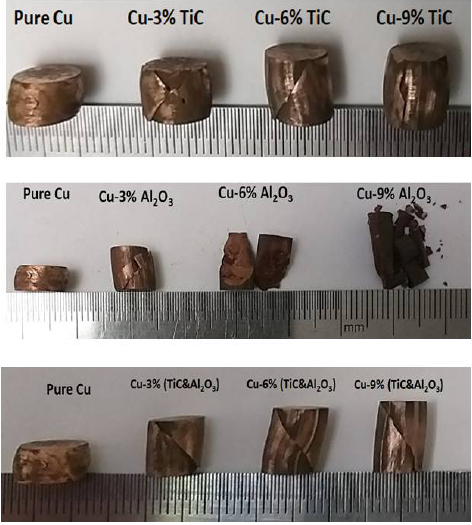
Figure 10. Compressed test samples for pure Cu and Cu matrix nanocomposites.